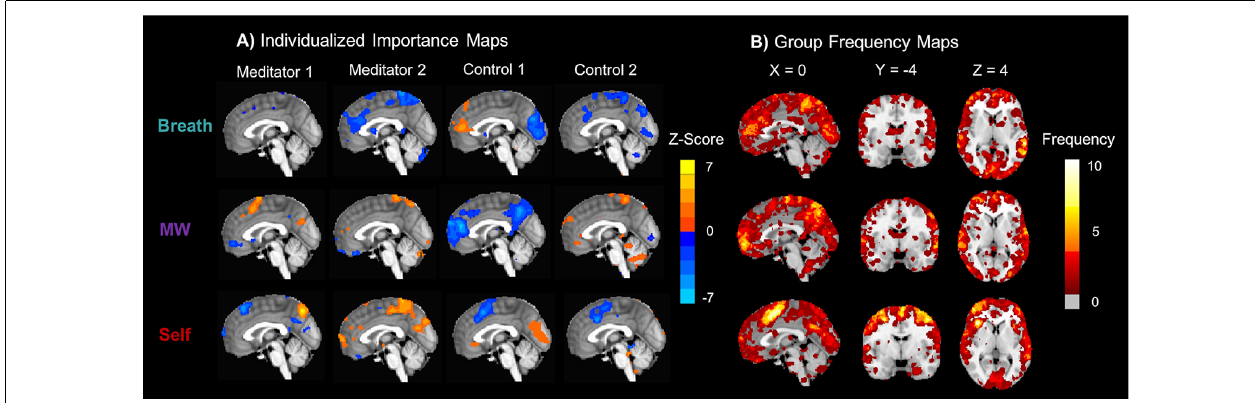
FIGURE 3 | Classifier importance maps representing voxels that accurately distinguish internal mental states. (A) Subject-level importance maps showing individualized brain patterns representing voxels that are important for distinguishing neural signatures of attention to the Breath, MW, and Self ( X = 0). For each task condition, importance values were computed by multiplying each voxel’s classifier weight for predicting the condition and the average activation during the condition (McDuff et al., 2009). The maps were thresholded at ± 2 SD and displayed on the MNI152 template to identify the most important voxels for each participant. Orange importance voxel indicates positive z -scored average activation values, and blue importance voxels indicate negative z -scored average activation values. (B) To initially characterize the distribution of voxels that supported accurate classification, group importance frequency maps indicate the number of participants for which the voxel accurately distinguished each mental state. All important voxels were summed, irrespective of average positive or negative z -scored activation. Frequency maps were also computed that independently summed positive ( Supplementary Figure S2A ) and negative ( Supplementary Figure S2B ) z -scored activation voxels, as well as histograms of frequency counts ( Supplementary Figures S2C–E ). Note that the maximum frequency for any importance map was 10/14.